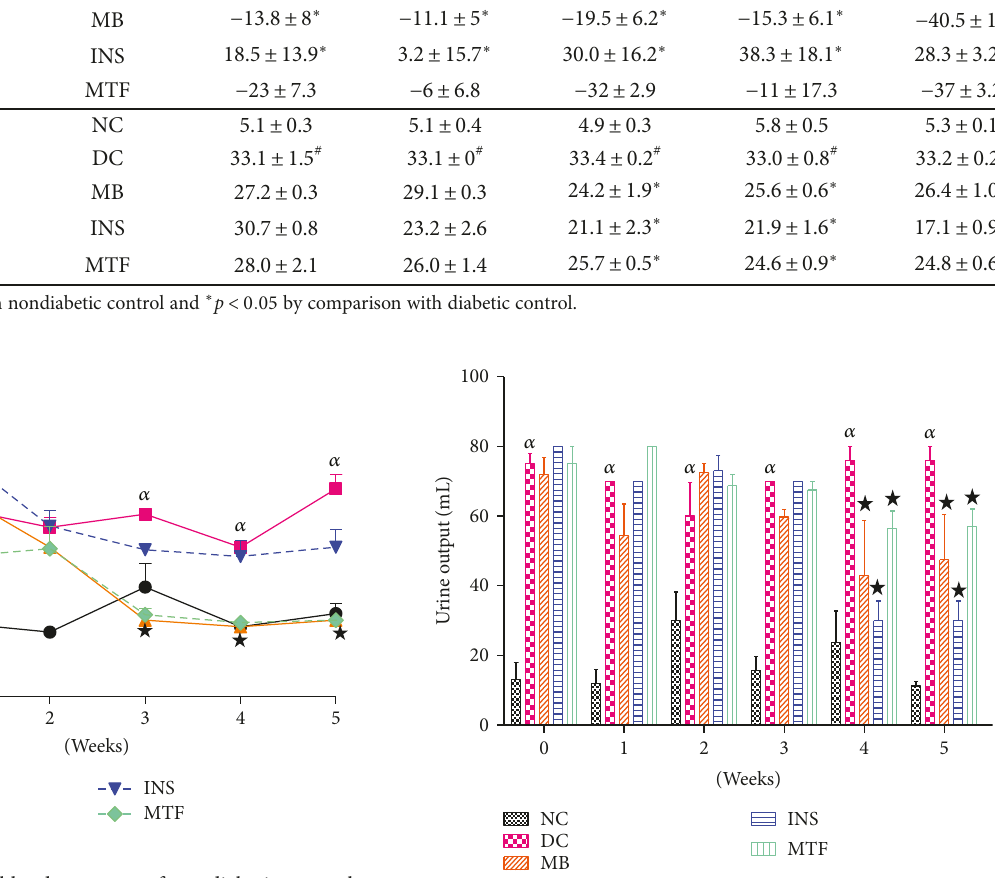
Figure 2: Urine output of nondiabetic controls, diabetic controls, and diabetic rats treated with M. balsamina , metformin, and insulin over a period of 5 weeks. Values are expressed as mean ± S EM . α p < 0 05 by comparison to nondiabetic control; ★ p < 0 05 by comparison with diabetic